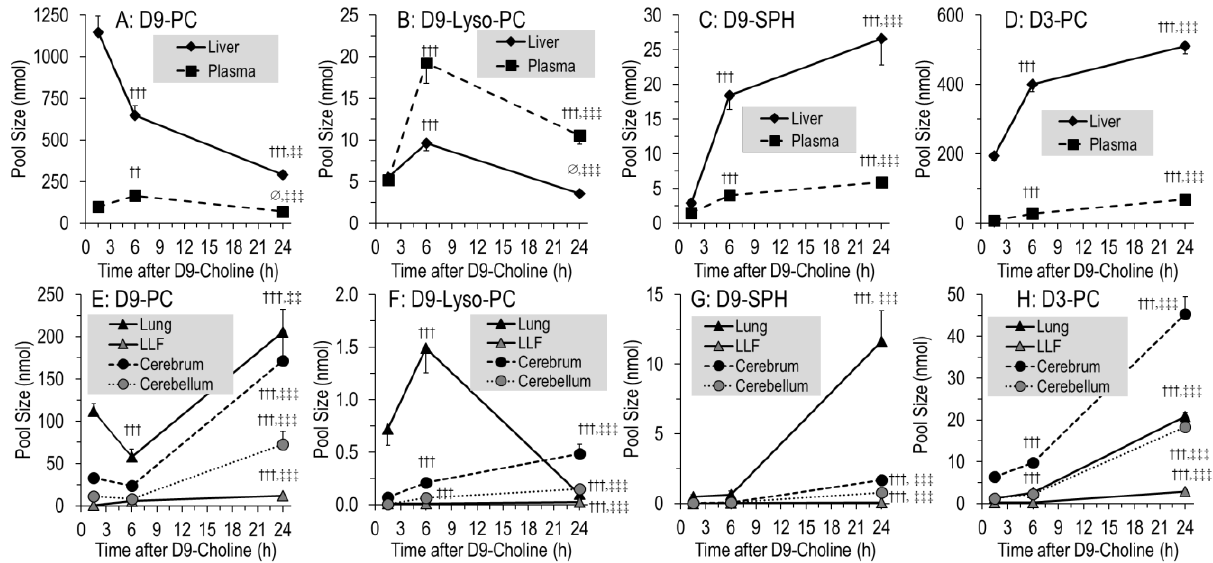
Figure 5. Pool size kinetics of D9-PC ( A , E ), D9-lyso-PC ( B , F ), D9-SPH ( C , G ) and D3-PC ( D , H ) in different organs. Data are means ± SE of 8–10 data points at 1.5 h, 6 h and 24 h, respectively, after intraperitoneal administration of 50 mg/kg D9-choline chloride. Abbreviations: D 9/3 -PC, D 9/3 -phosphatidylcholine; D9-Lyso-PC, D9-lyso-phosphatidylcholine; D9-SPH, D9-sphingomyelin, LLF, lung lavage fluid; ∅ , not significant, ††, p < 0.01, †††, p < 0.001 vs. 1.5 h; ‡‡, p < 0.01, ‡‡‡, p < 0.001 vs. 6